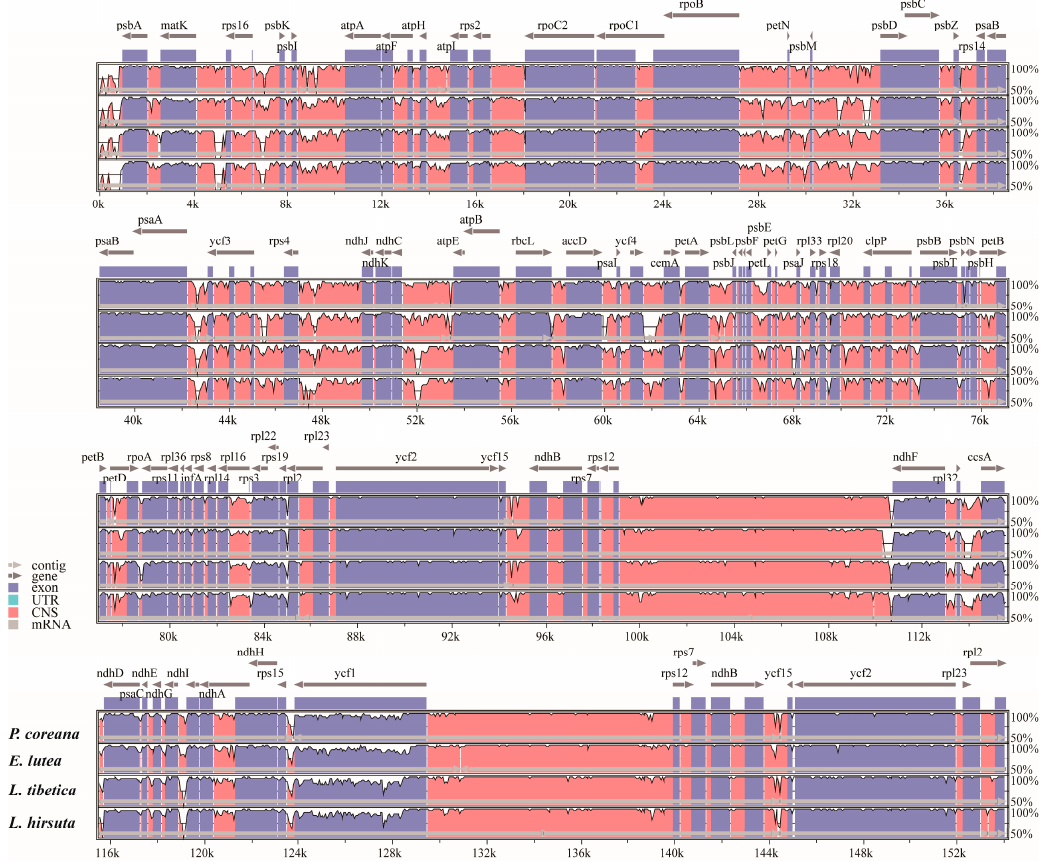
Figure 4. Comparison of five chloroplast genomes using the mVISTA alignment program with Rehmannia chingii as a reference. The x -axis represents the coordinates in the chloroplast genome. The y -axis indicates the average percent identity of sequence similarity in the aligned regions, ranging between 50% and 100%. Genome regions are color coded as protein coding, rRNA coding, tRNA coding or conserved noncoding sequences (CNS).